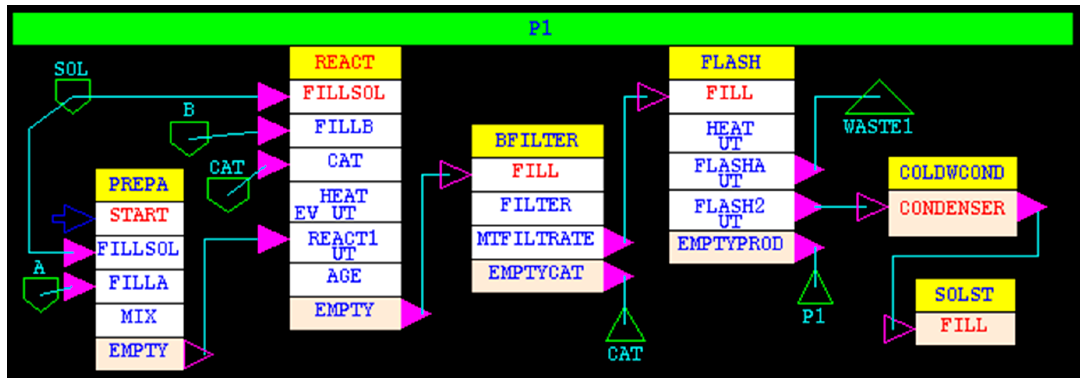
Figure 12. Recipe network of a specialty chemical process. Table 1. Details of the recipe for P1.